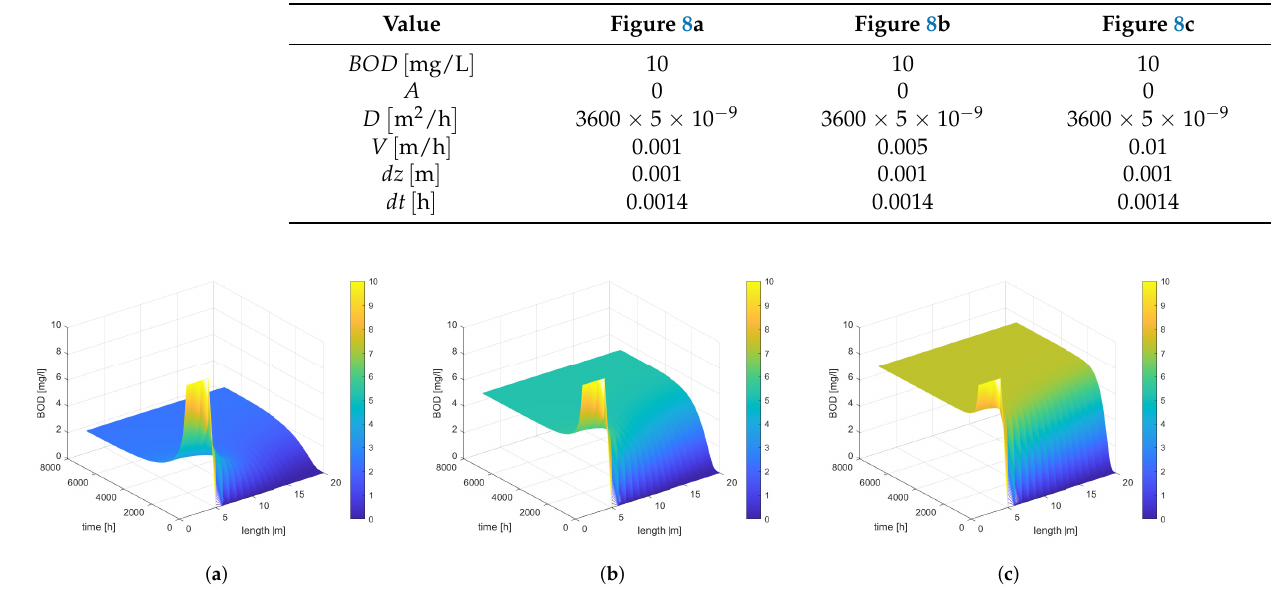
Figure 8. BOD distribution including diffusion for V = 0.001 ( a ) V = 0.005 ( b ) V = 0.01 ( c ). As the velocity increases over the same length of time, the value of the BOD concentra- tion increases. Changes in the BOD concentration at different velocities in the initial time moments are shown in Figure 9.